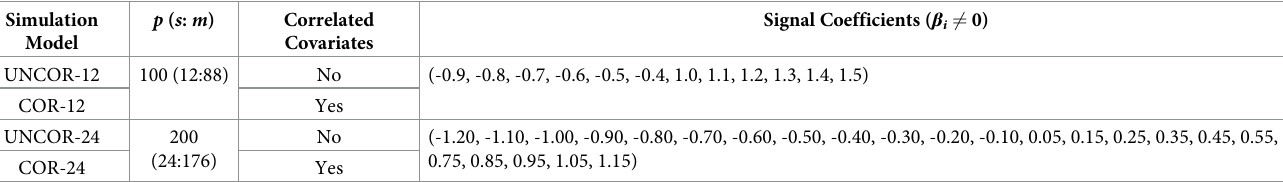
Table 1. Number of covariates ( p ), ratio of number of signal to number of noise covariates ( s : m ), and the nonzero regression coefficients corresponding to the sig- nal covariates for the four simulation models. Simulation